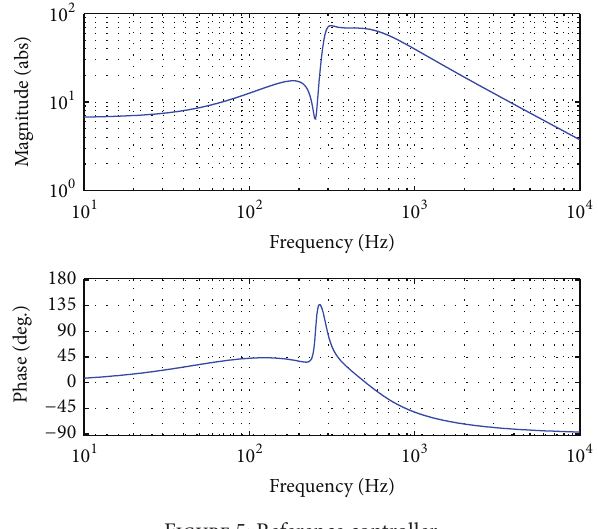
Figure 5: Reference controller. Table 2: Parameters for the reference PD